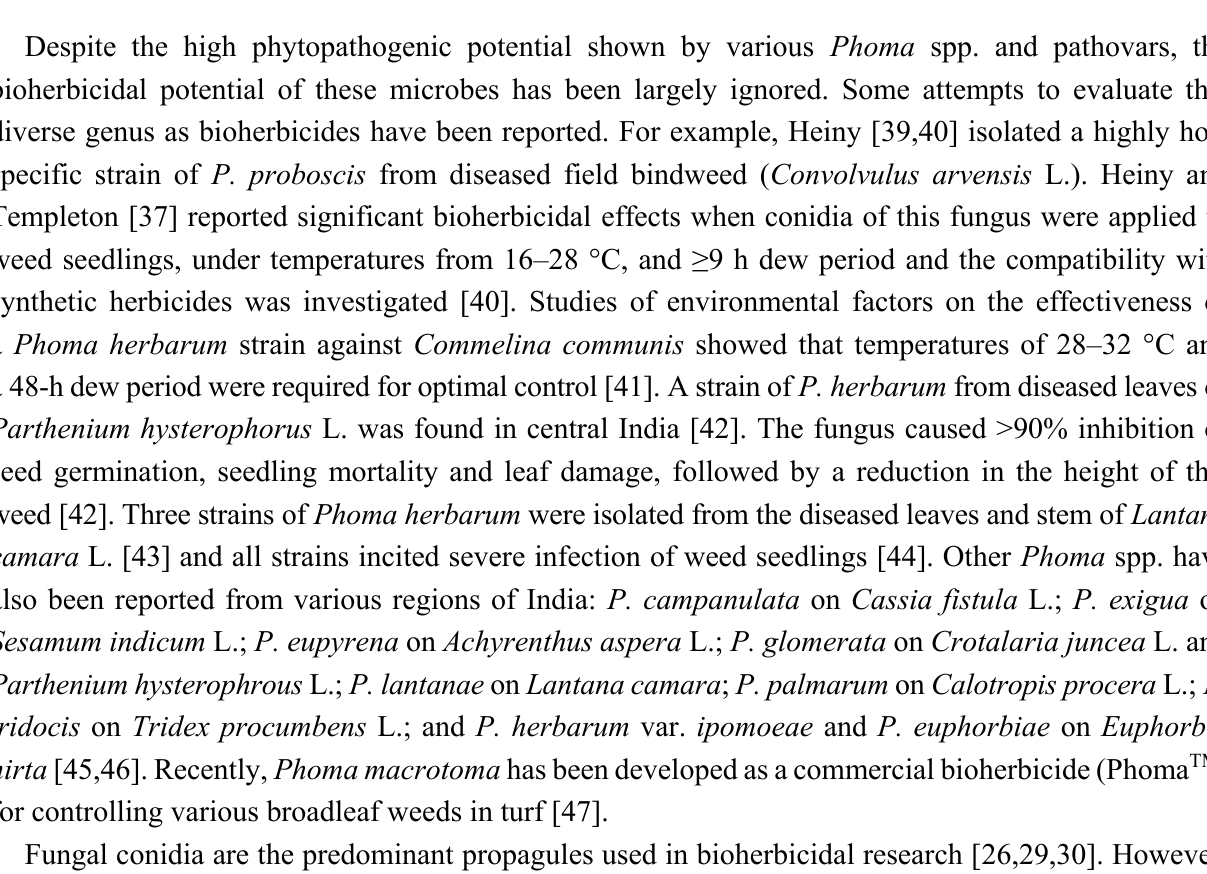
Figure 11. Disease progression of P. commelinicola on field-grown C. diffusa over a 21-day period after inoculation. The relationship for P. commelinicola disease progression is best described by the equation: Y = −0.39 + 0.31 X − 0.04 X 2 , R 2 = 0.96. Error bars represent Fisher’s LSD ( p =